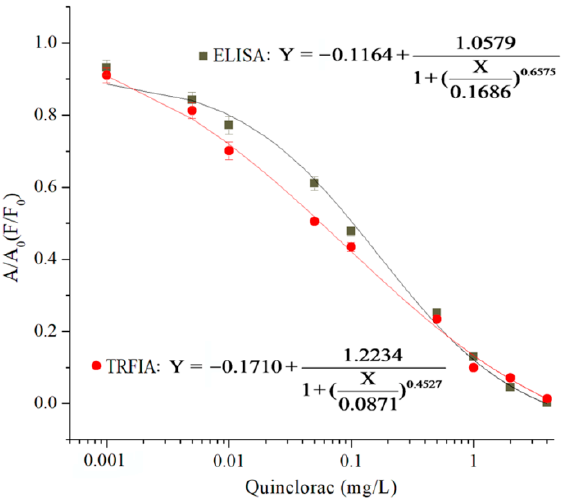
Figure 2. The standard curves of ELISA and TRFIA for quinclorac ( n = 3).